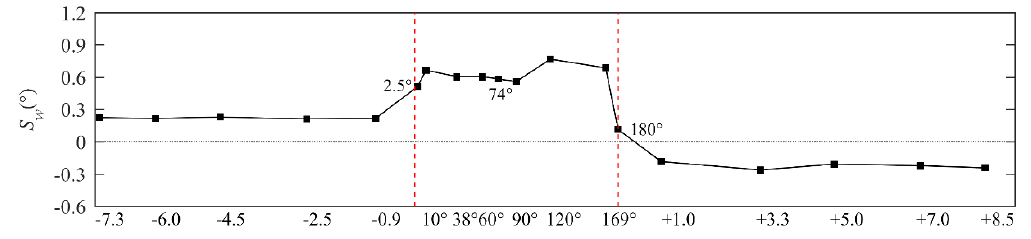
Figure 7. Evolution of the transverse slope along the flume.